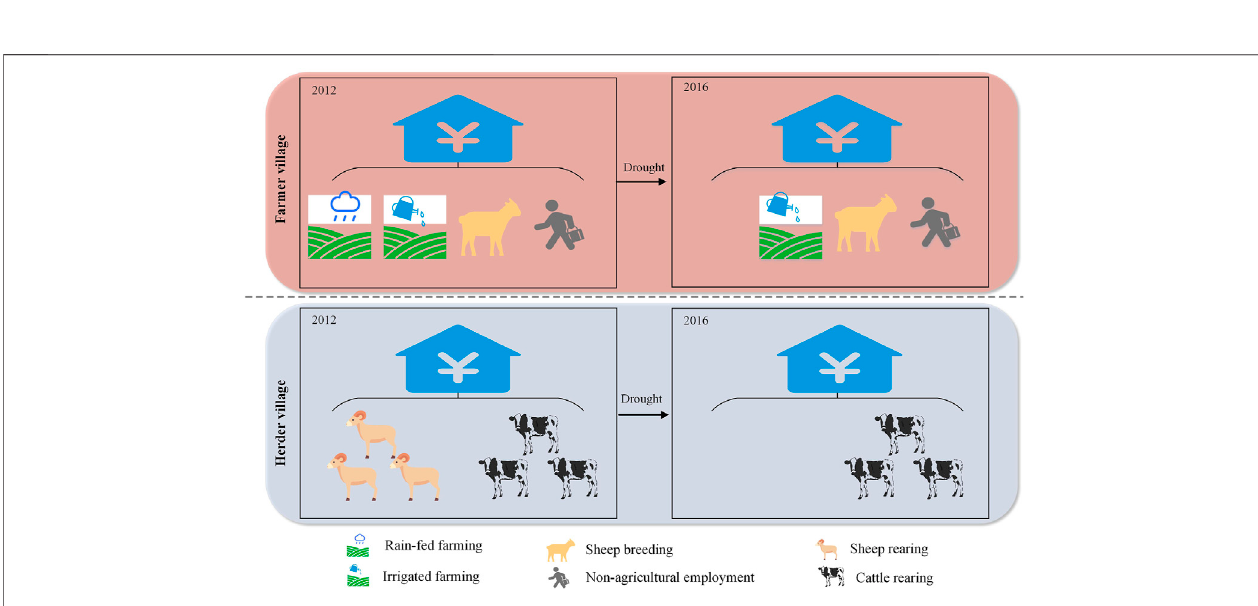
FIGURE 4 | Changes in livelihood activities of farmers and herders in 2012 and